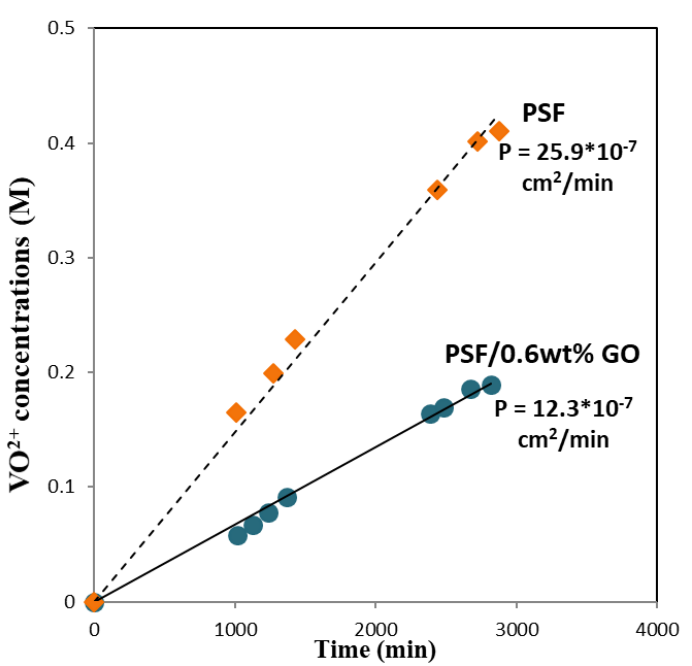
Figure 7. Vanadium ion permeability of PSF/GO membranes.